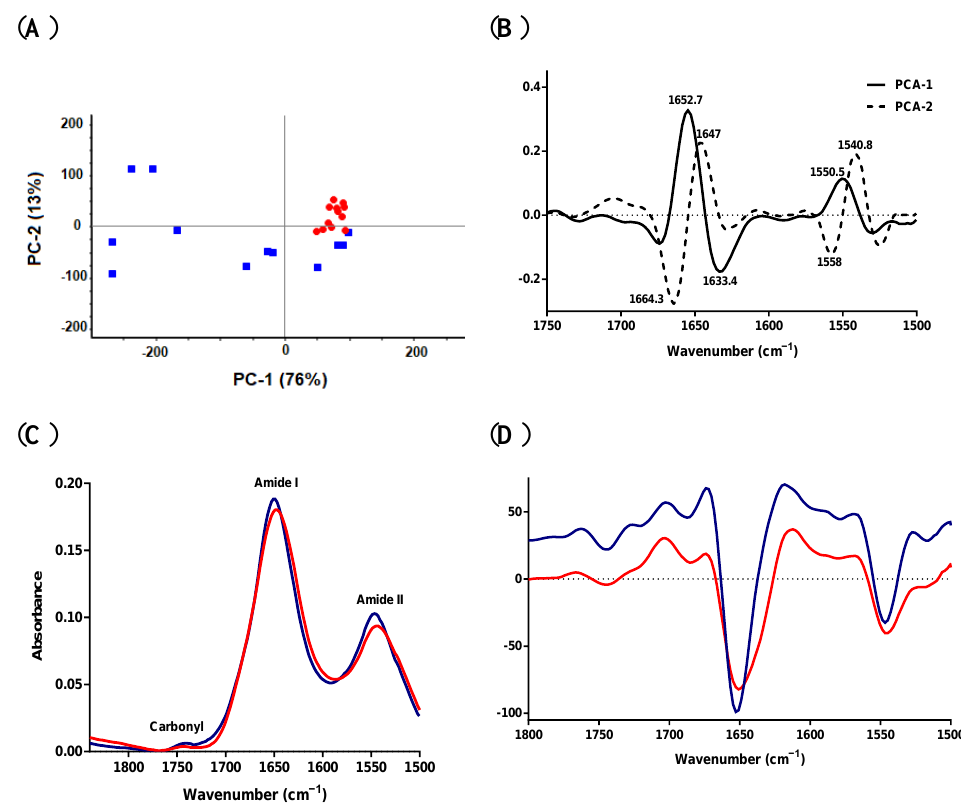
Figure 2. SR-FTIR spectra of protein-carbonyl region from S. aureus ATCC 29213 (blue) and S. epidermidis ATCC 12228 (red). ( A ) PCA score plots. ( B ) Loading plots of PC-1 and PC-2 of PCA models ( C ) Unit-vector-normalized average raw spectra. ( D ) Normalized reduced Savitzky–Golay second-derivative average spectra of protein-carbonyl region.